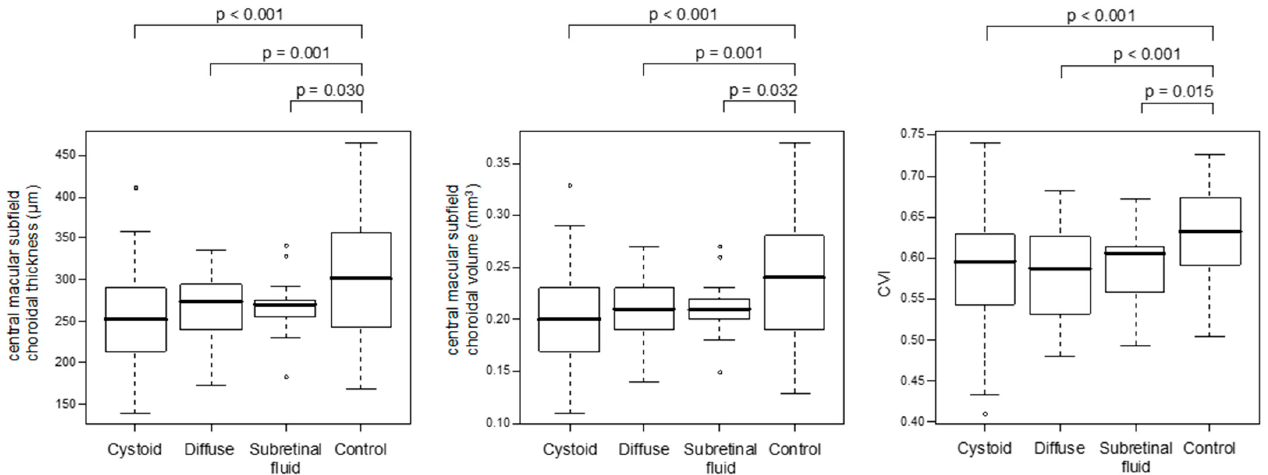
Figure 2. Selected choroidal parameters in eyes with various types of DME and non-diabetic controls. Hollow dots indicate outlier observations (i.e., values exceeding 1.5 the interquartile range above the upper quartile and bellow the lower quartile); p -values from the univariate mixed-effect models (with covariates) comparing the study groups identified based on the type of DME with non-diabetic controls; only p -values < 0.05 are marked; covariates included in each model: age in years, sex (male/female), DR (NPDR/PDR), PRP (no/yes). CVI = choroidal vascularity index.